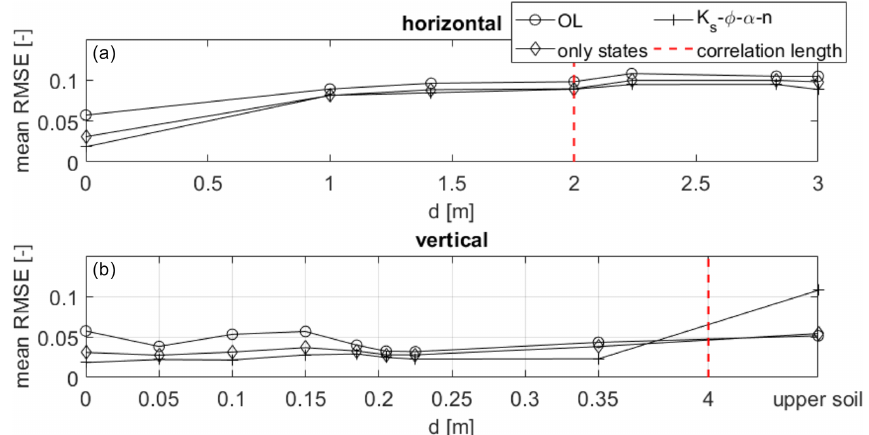
Figure 11. Spatially and temporally averaged RMSE values at horizontal distance d from the observation locations for the heterogeneous scenario. In panel (a) , d is the horizontal distance and is the vertical distance in panel (b) . The red line indicates the correlation length of the parameter fields.